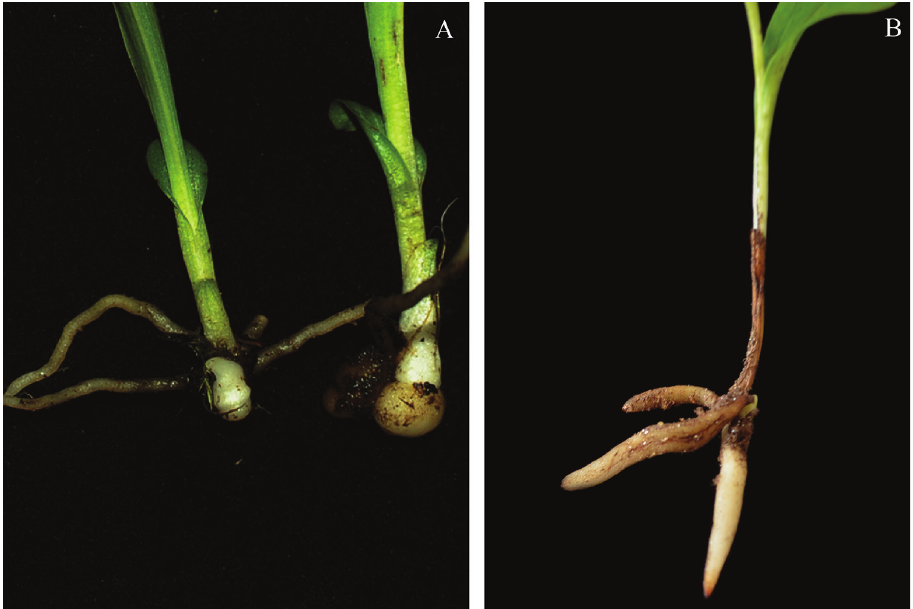
Figure 4. Subterranean parts of Herminium and Platanthera . A Herminium sp . B Platanthera